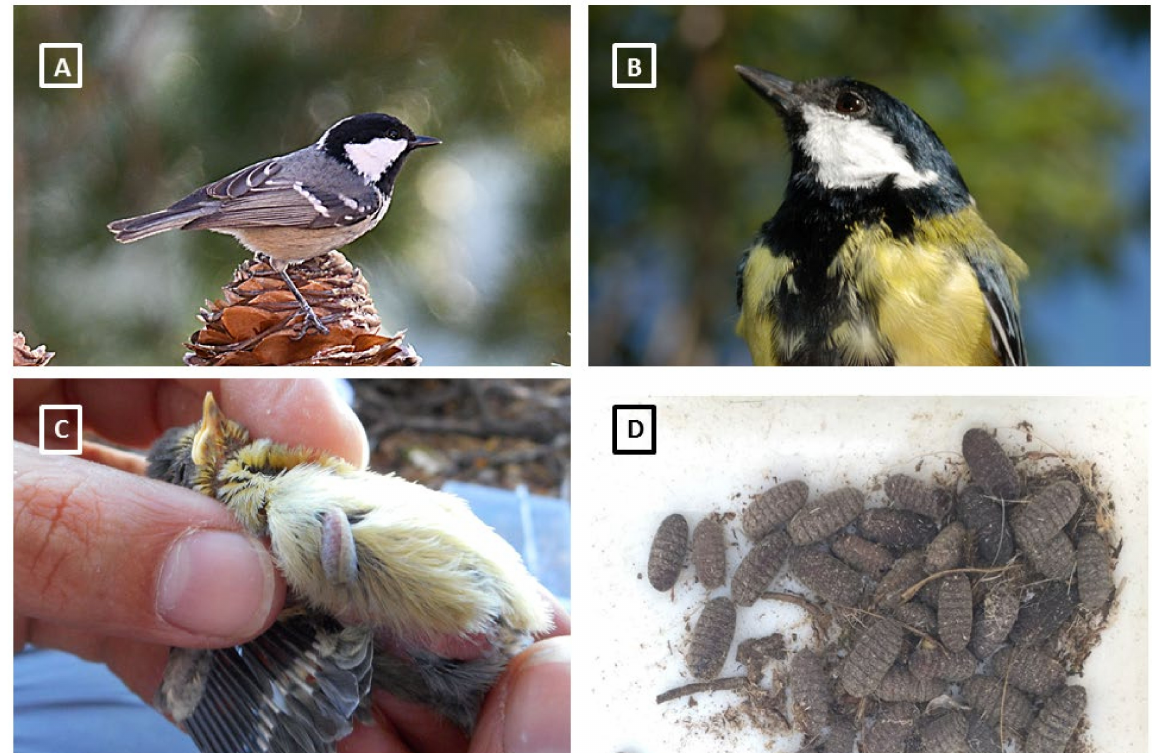
Figure 1. Host species: ( A ) coal tit, ( B ) great tit. A blowfly larva parasitising a blue tit ( Cyanistes caeruleus ) nestling ( C ). Several blowfly puparia collected from a nest ( D ). Photos A and B courtesy of Mar